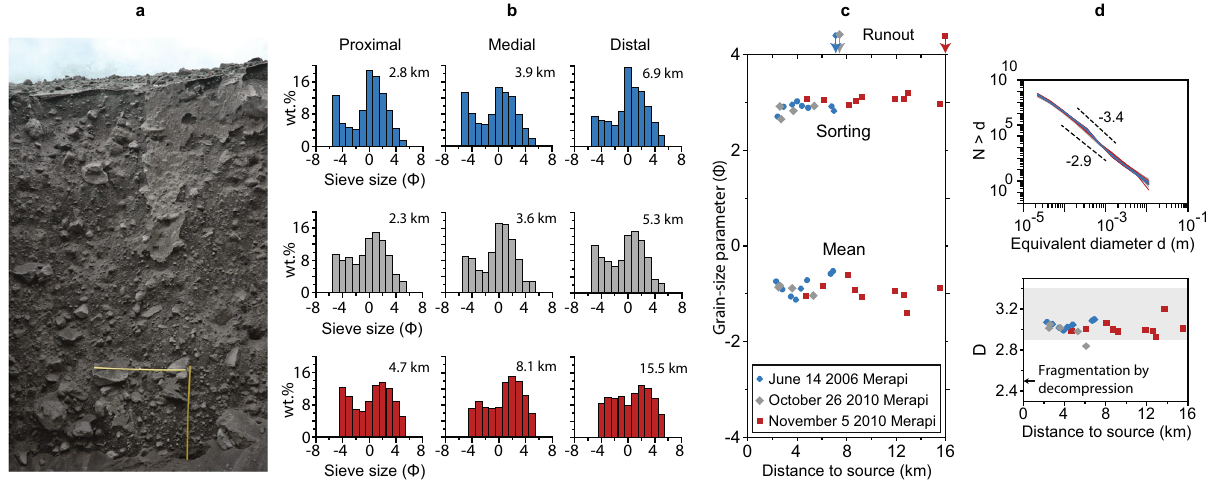
Fig. 1 | Block-and-ash fl ow deposits at Merapi volcano. a Outcrop of the block- and-ash fl ow deposit from the June 14, 2006, event at Merapi volcano at 2.8km from source. Each yellow bar is 1m long. b Proximal, medial and distal grain-size distributions of samples collected at Merapi for all three BAFs of June 14, 2006 (blue), October 26, 2010 (grey) and November 5, 2010 (red) ( Φ = − log2( d [mm]). Note that samples in the “ proximal ” region were collected close to the proximal/ media transition. c Sorting and mean grain-size parameters for all samples plotted withdistance.Therunoutofeacheventisindicatedonthetopwithverticalarrows.